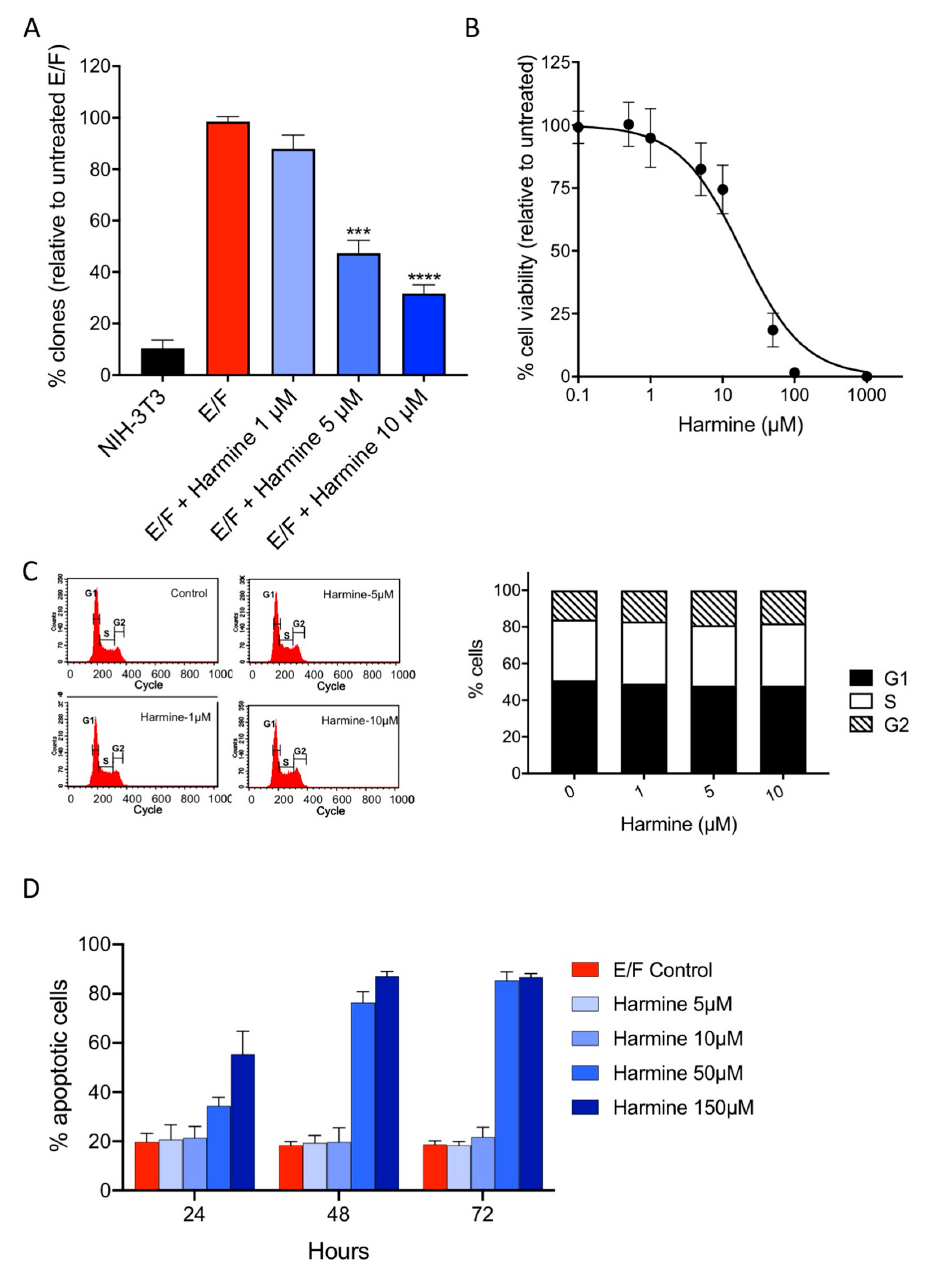
Figure 6. Effect of harmine on E/F cell anchorage-independent growth. ( A ) NIH-3T3 and E/F cells were cultured, in the absence or presence of different concentrations of harmine (as indicated), in methylcellulose semi-solid medium for 3 weeks. Then, the colonies formed were counted. The results are expressed as a percentage of untreated E/F control (means ± SEM) from three independent experiments. ( B ) MTT assay performed on adherent E/F cells cultured in the presence of different concentrations of harmine for 72 h. The results are expressed as a percentage of untreated E/F control (means ± SD) from three independent experiments. ( C ) Flow cytometry analysis of E/F cells cultured during 72 h using standard operating conditions in the presence of increasing concentrations of harmine. Cells were labeled with propidium iodide and the % of cells in either G1/S/G2 phases was estimated. The results presented are from one representative experiment. ( D ) Early detection of apoptosis using Annexin V/propidium iodide staining on E/F cells cultured in the presence of different concentrations of harmine for 72 h. The results are presented as percentages ± SD of Annexin V-positive/propidium iodide-negative cells for three independent experiments.